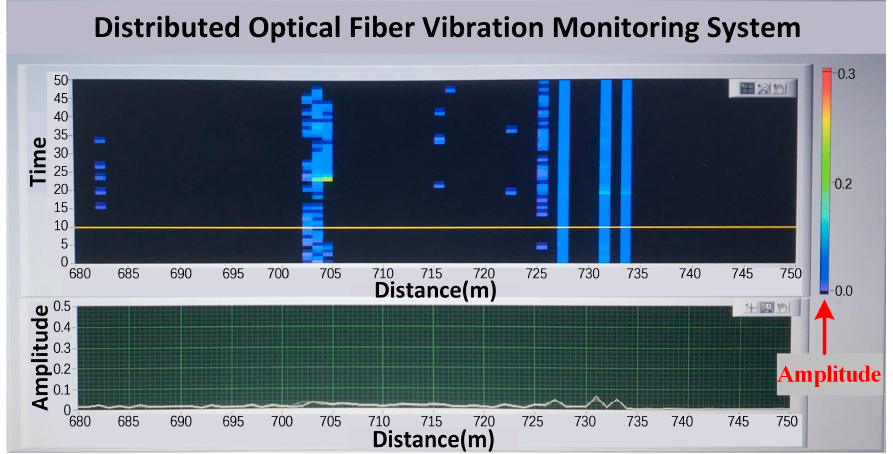
Figure 2. The interface of optical-fiber vibration monitoring for cable PDs.